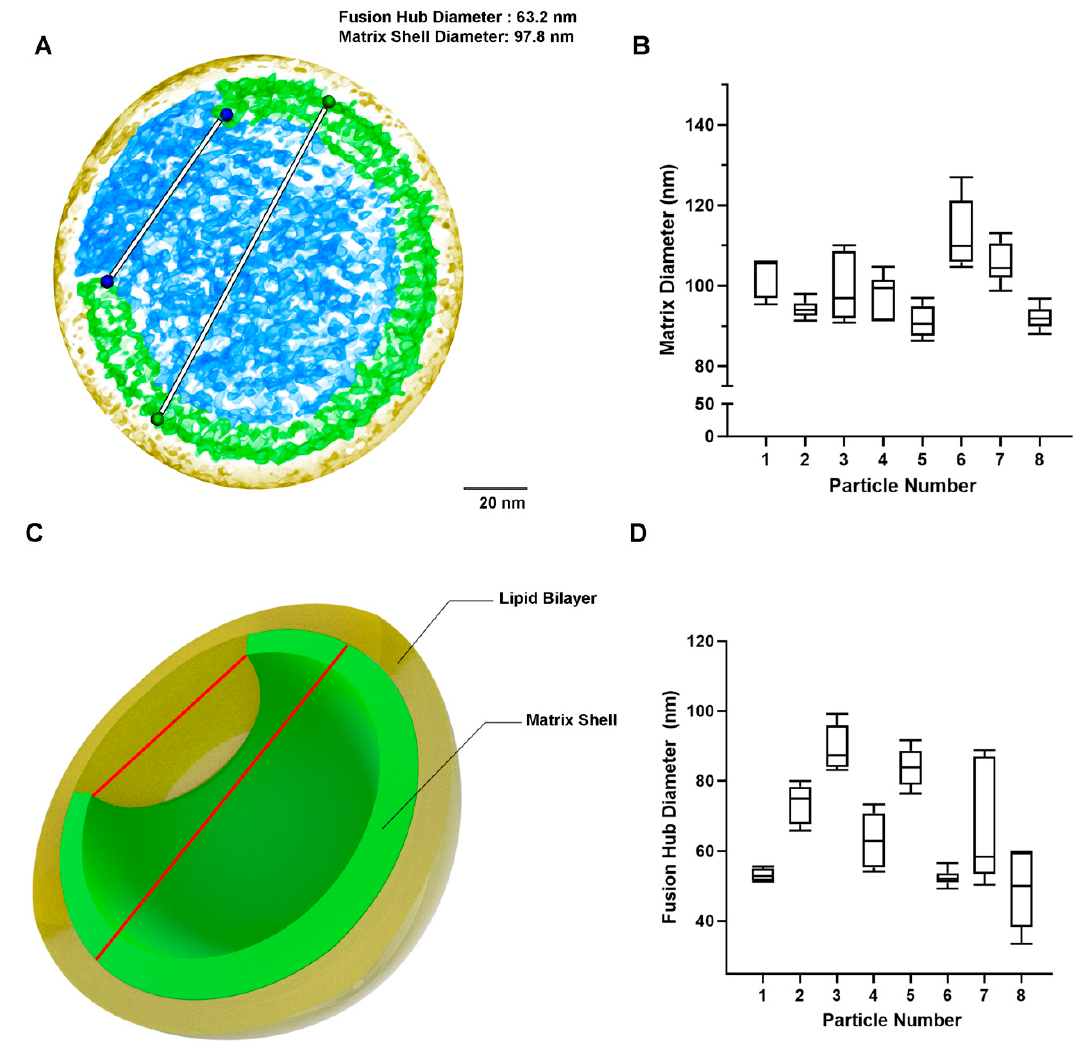
Figure 3. Visualization and measurements of the HIV-1 MA shell diameter and fusion hub gap. ( A ) A representative Cryo-EM particle from EMD-4020 is shown with distances between same-colored pseudoatoms representing the matrix shell diameter and fusion gap length. The distance between the two blue pseudoatoms is the length of the fusion hub diameter, while the distance between the two green pseudoatoms is the length of the fusion hub diameter. ( B ) HIV particle fusion hub measurements. A total of 8 HIV-1 particles were assessed from EMD-4020 and EMD-13085. ( C ) A 3D conceptual image of an HIV-1 particle. The outer yellow color denotes the phospholipid bilayer, whereas the inner green color denotes the matrix shell. The fusion hub gap can be seen by space marked with the shorter red line, marking the fusion hub diameter. The longer red line marks the matrix shell diameter. ( D ) HIV particle matrix diameter measurements.